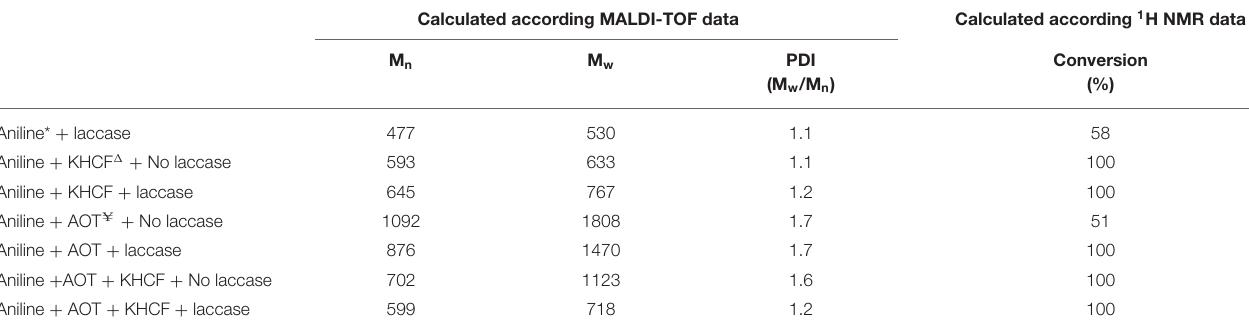
TABLE 1 | Characterization of the products of aniline polymerization by laccase in the presence of additives. Calculated according MALDI-TOF